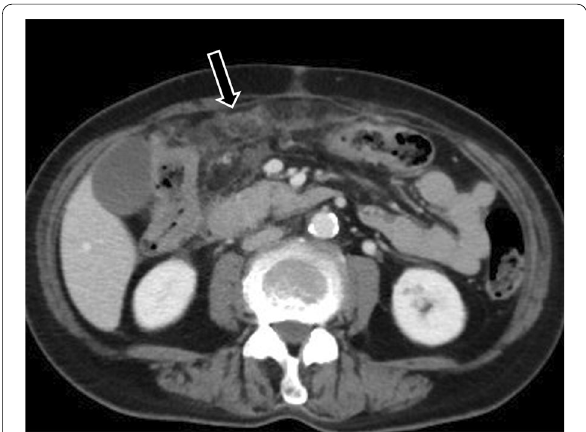
Fig. 8 Metastatic peritoneal disease on staging CT, in a 61-year-old female with invasive lobular carcinoma. Axial contrast-enhanced CT image shows multiple, ill-defined, tiny nodules in the peritoneum (arrow), which were highly suspicious for metastatic disease. This was confirmed on diagnostic laparoscopy and biopsy